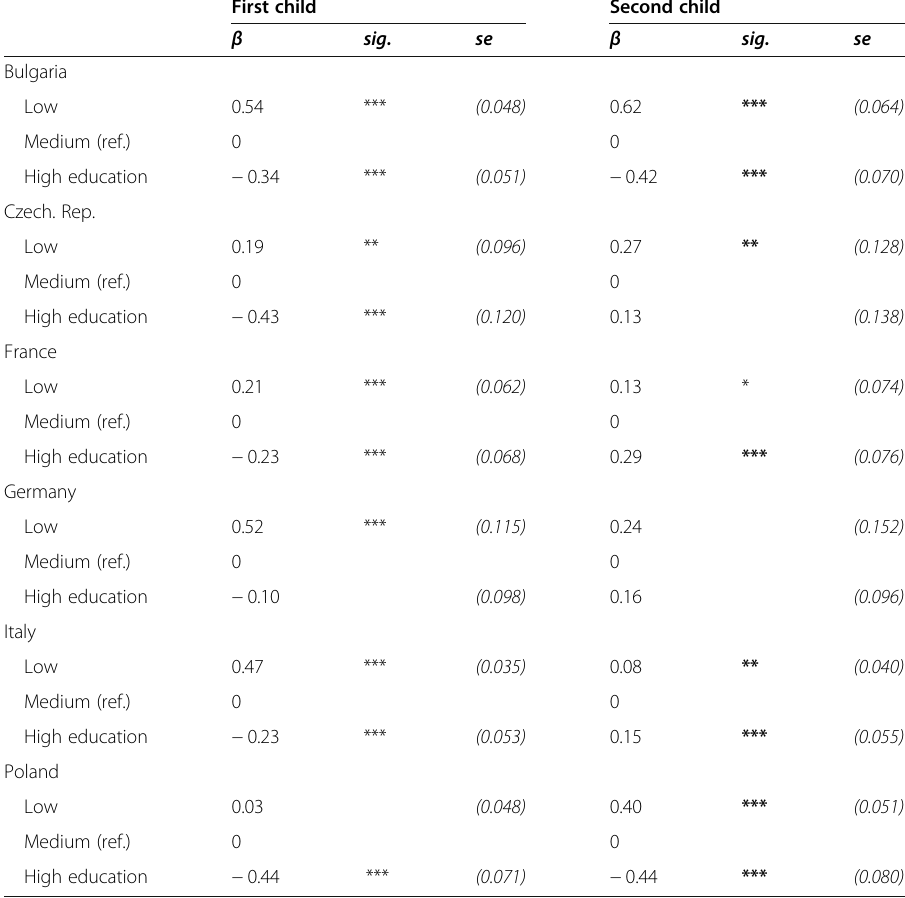
Table 3 Simultaneous hazard model for the first and the second childbirth including the interaction between country and education (ref. medium level). Parameter estimates, significance values and standard errors